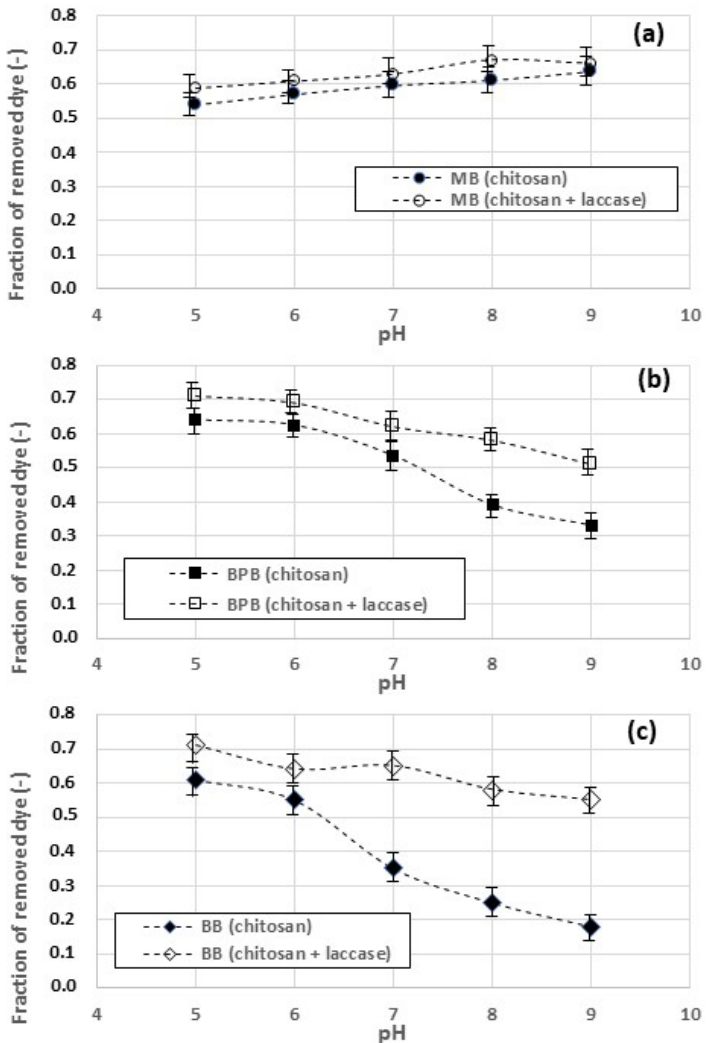
Figure 6. Amounts of dyes removed in the presence of chitosan hydrogel with immobilized laccase: methylene blue ( a ), bromophenol blue ( b ), Coomassie brilliant blue ( c ). S/L ratio = 1/100, contact time = 120 min.